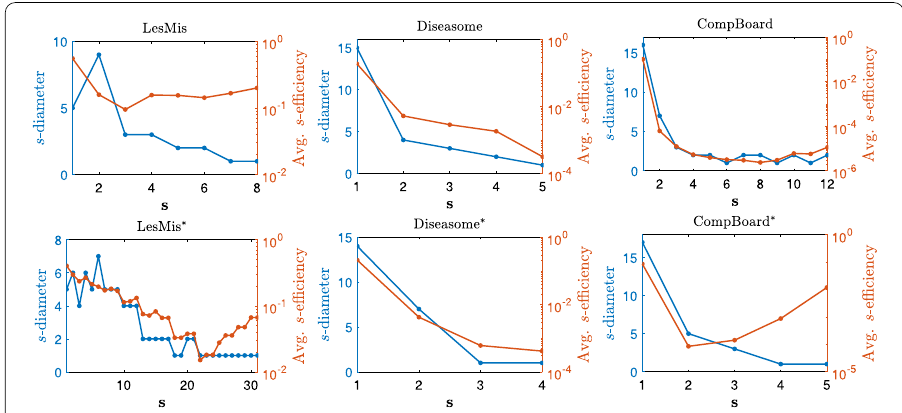
Figure 5 Maximum s -diameter over all s -components and average s -efficiency for LesMis, Diseasome, and CompBoard (top row) and their dual hypergraphs (bottom row). Note the s -diameter values are in linear scale whereas the s -efficiency values are in logarithmic